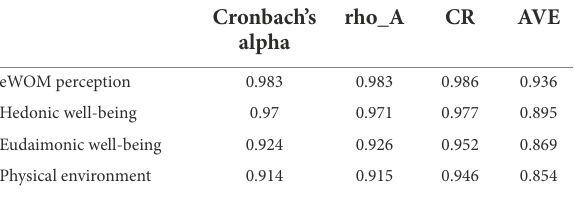
TABLE 3 Study 2: The facet reliability and validity of each variable (physical